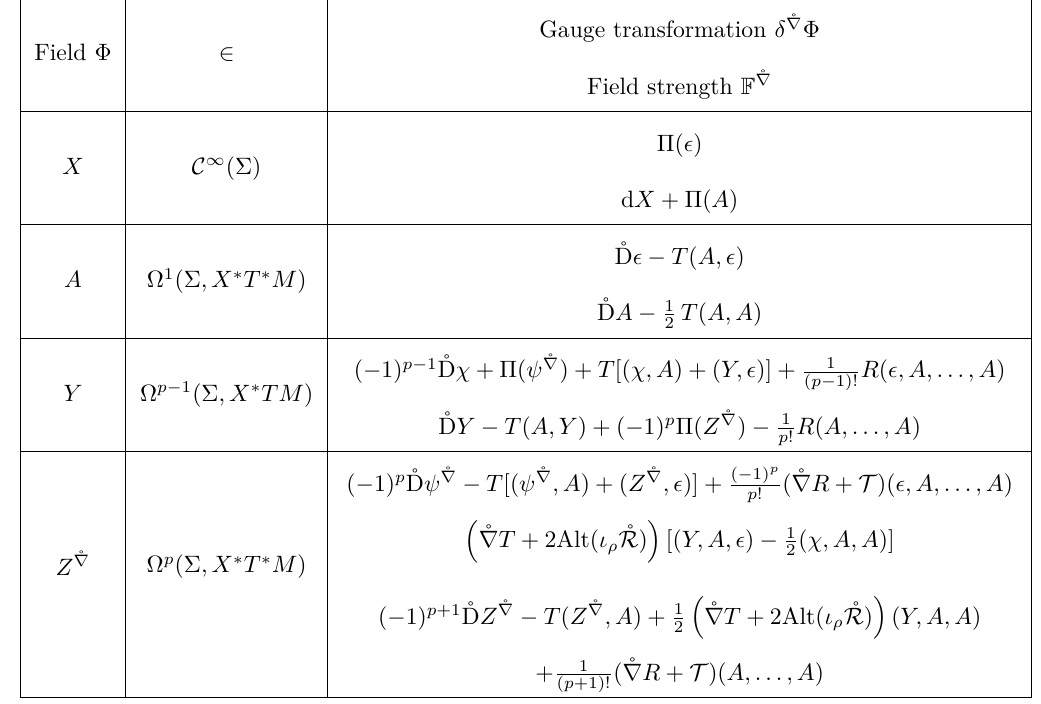
Table 1 . Covariant gauge transformations and field strengths F ˚ ∇ = ( F ˚ ∇ , G ˚ ∇ , F ˚ ∇ , G ˚ ∇ ) for the collection of fields Φ = ( X, A, Y, Z ˚ ∇ ) on Σ ≡ Σ . We have defined T = − ˚ ∇ Π . Composition p +1